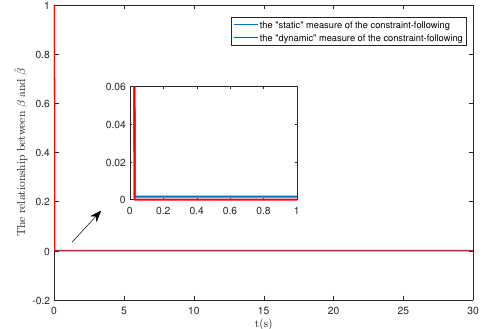
Figure 8. The relationship between β and ˆ β